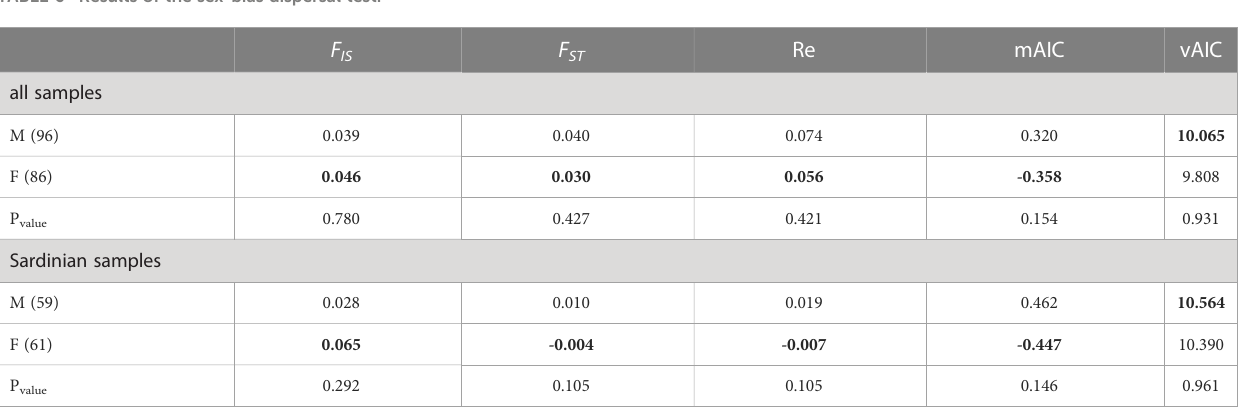
TABLE 6 Results of the sex-bias dispersal